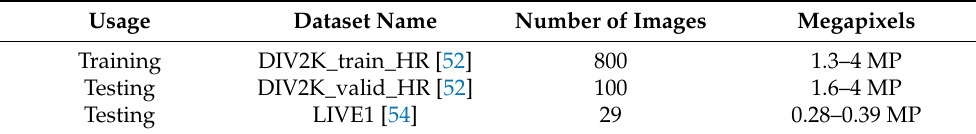
Table 1. Image datasets.